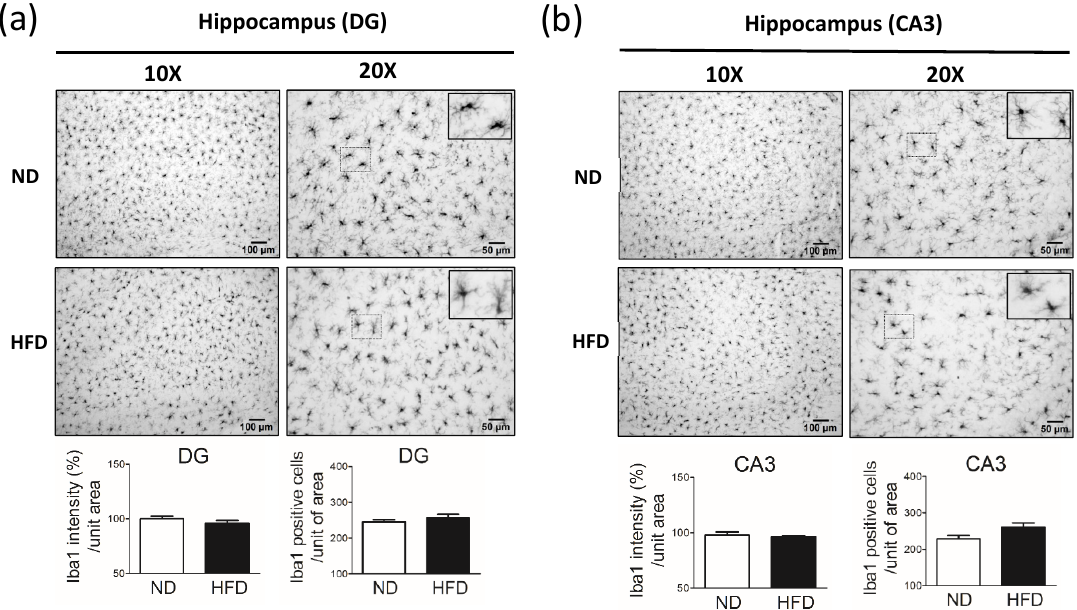
Figure 10. Immunostaining of microglial cells (IbA1-positive cells) in the hippocampus dentate gyrus (DG) and CA3 after rat were fed a normal diet (ND, control, n = 5) or 45% high-fat diet (HFD, n = 5) for 30 weeks. Data were captured with 10X (scale bar = 100 μ m) and 20X (scale bar = 50 μ m) objectives. Immunostaining of IbA1 (microglial cells) in the hippocampus ( a ) and DG ( b ). IbA1 immuno-intensity (%) and IbA1-positive cells per unit of area (10X objective) were quantified by using cellSens Dimension software (Olympus). Data are expressed as the mean ± SEM.